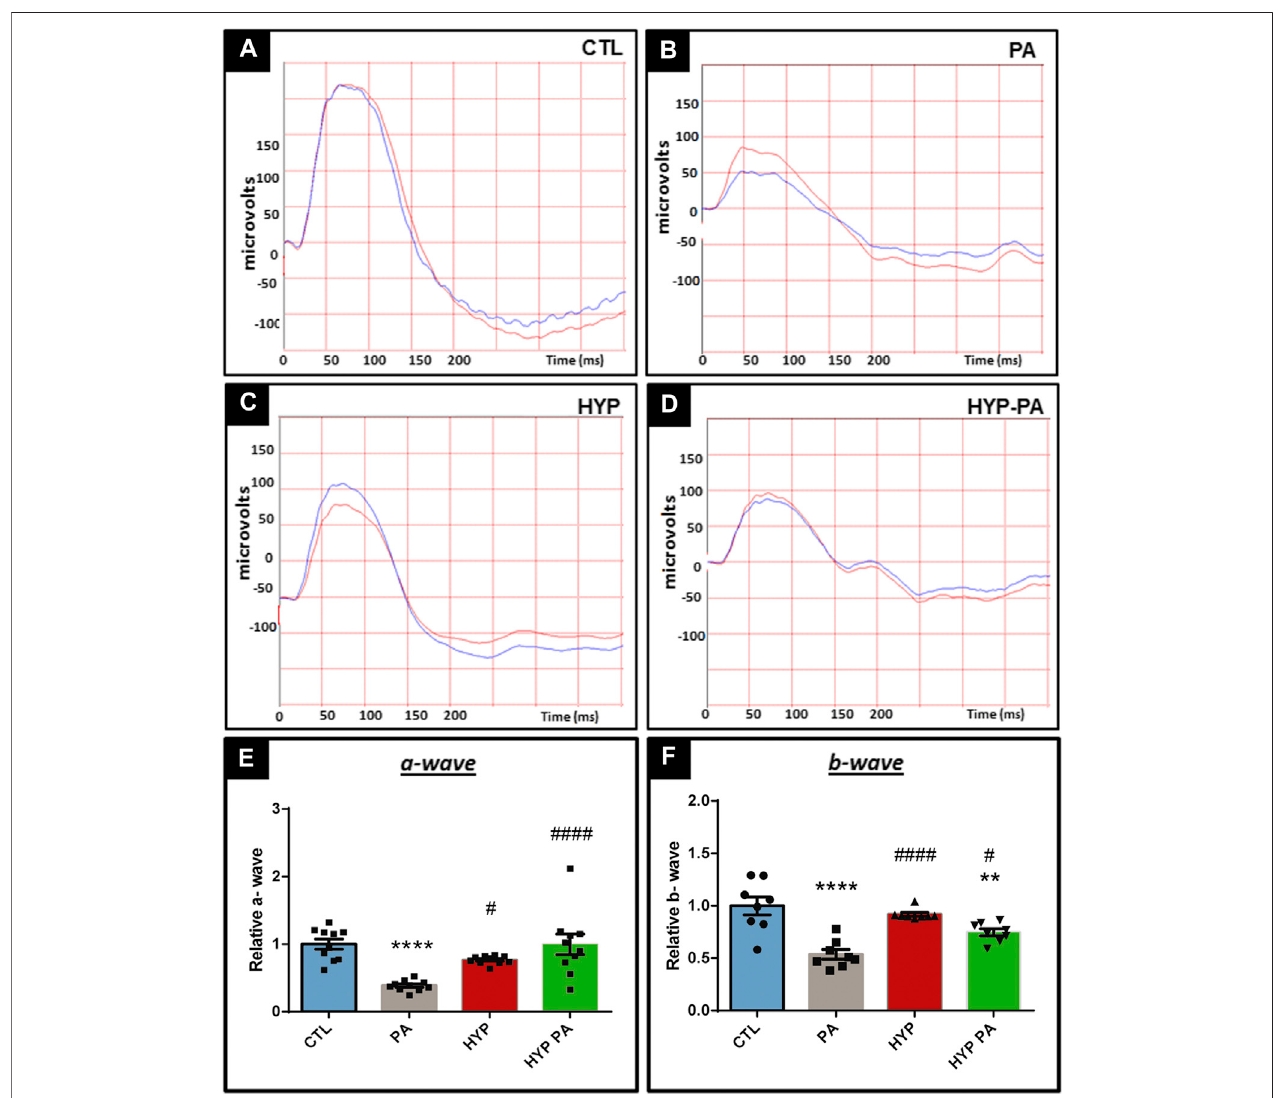
FIGURE 2 | Hypothermia prevents changes in the electroretinogram induced by perinatal asphyxia. Representative electroretinograms of 45 day-old animals (n (cid:2) 10pergroup)subjectedtoPAwithandwithouthypothermicshock. (A) :Control(CTL), (B) :Normothermicperinatalasphyxia(PA), (C) :Hypothermiaduringperinatal asphyxia (HYP), and (D) : Hypothermic shock after perinatal asphyxia (HYP-PA). (E) : Amplitude of the a-wave in the four experimental groups. Perinatal asphyxia (PA) induced a signi fi cant decrease in the a-wave with respect to controls (CTL), whereas both hypothermic treatments (HYP and HYP-PA) prevented it. Two way ANOVA, signi fi cant interaction F (cid:2) 11.14, p < 0.0001, Tukey´s multiple comparison test, p < 0.0001 (CTL vs. PA), p (cid:2) 0.019 (PA vs. HYP), p < 0.0001 (PA vs. HYP-PA). (F) : Amplitude ofthe b-wave in the four experimental groups. Perinatal asphyxia (PA) induced asigni fi cantdecrease in the b-wave compared to controls (CTL), whereas both hypothermic treatments (HYP and HYP-PA) prevented it. Two way ANOVA, signi fi cant interaction F (cid:2) 15.62, p < 0.0001, Tukey´s multiple comparison test, p < 0.0001 (CTL vs. PA), p (cid:2) 0.0095 (CTL vs. HYP-PA), p < 0.0001 (PA vs. HYP), p (cid:2) 0.036 (PA vs. HYP-PA). Each bar represents the mean ± SEM of 10 animals. Asterisks indicate signi fi cant differences with CTL. **: p < 0.01; ****: p < 0.0001. Pound signs indicate signi fi cant differences with PA. #: p < 0.05; ####: p < 0.0001.